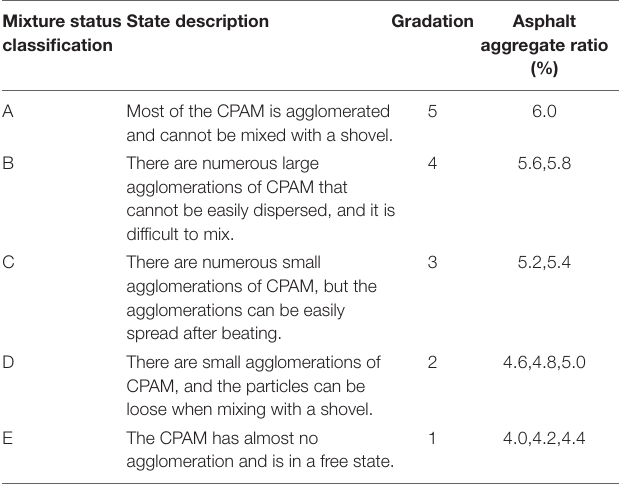
TABLE 8 | Test results of low-temperature workability of CPAM. Mixture status State description Gradation Asphalt classification